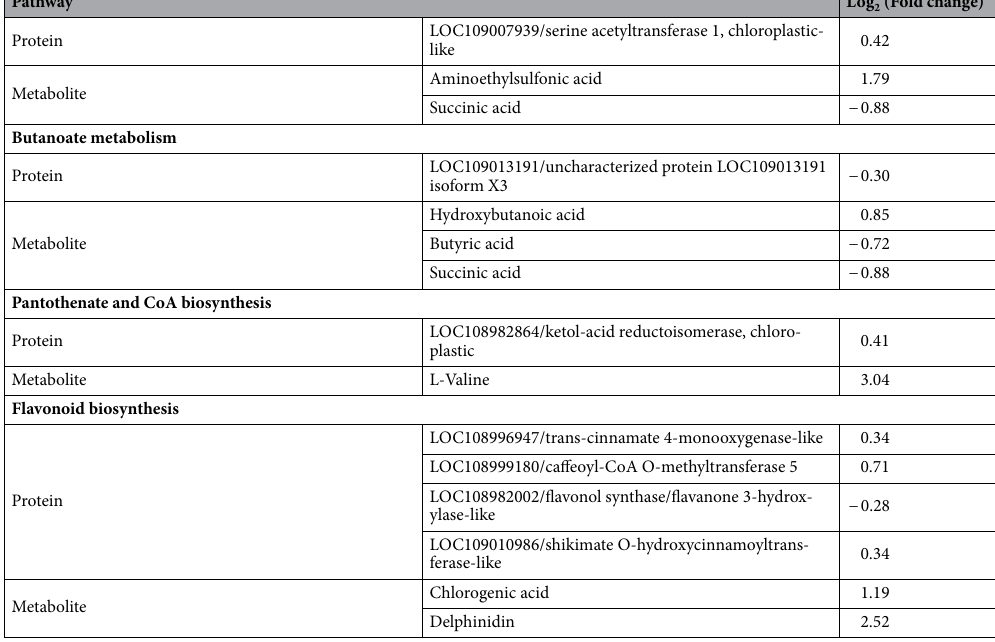
Table 1. The core KEGG biological pathway and its changes in the correlation analysis results of DEP and DEM in pecan after 48 h of salt stress.